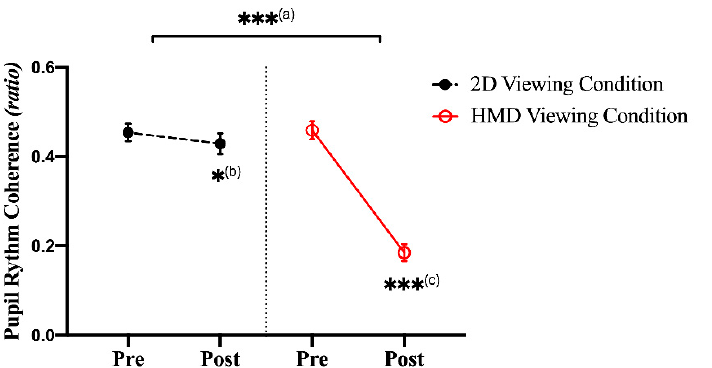
Figure 7. Representation of the PRC ratio for motion sickness between the 2D and HMD conditions. There was a significant difference based on a paired t -test and ANCOVA (* p < 0.05; *** p < 0.001). ( a ) The ANCOVA test between the 2D and HMD viewing condition. ( b ) A paired t -test between pre- and post-viewing in the 2D condition. ( c ) A paired t -test between pre- and post-viewing in the HMD condition.